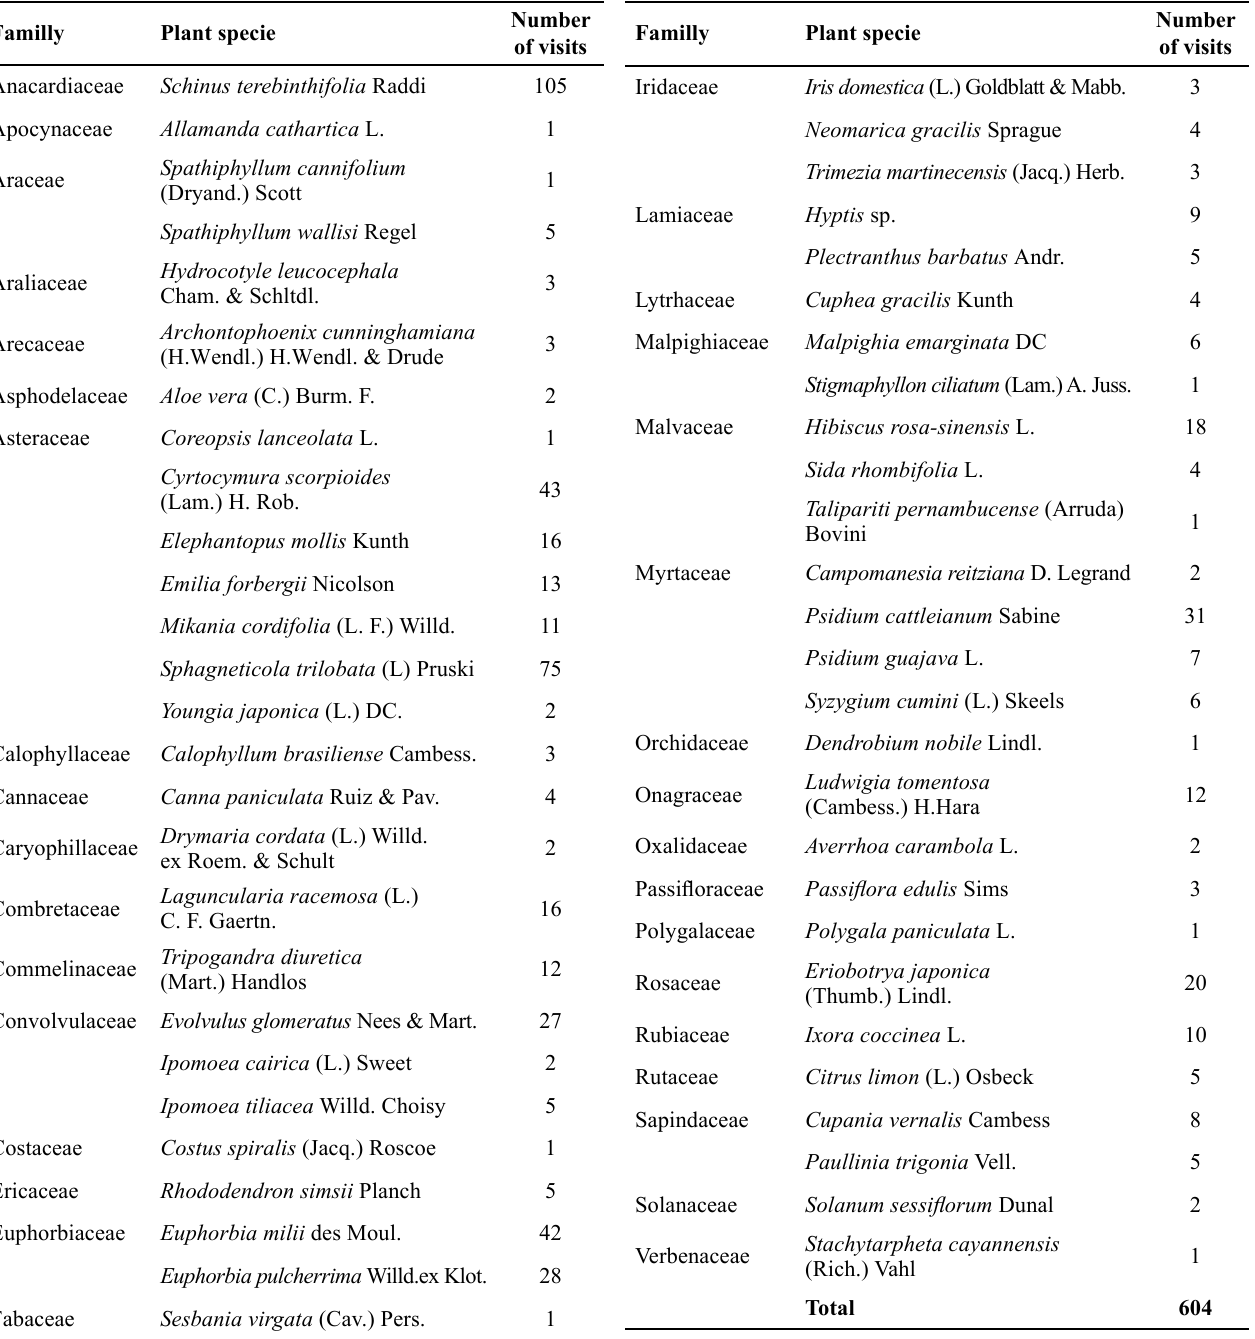
Table 3 . List of plant species visited by bees in Ilha Grande, São Francisco do Sul,